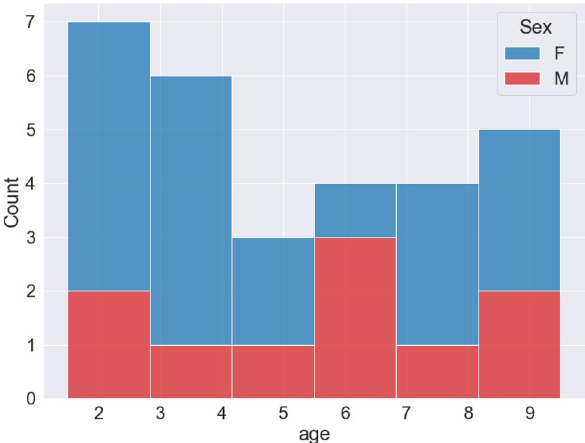
Figure. 1. Number of dogs by age and by sex. The dataset contains slightly more female than male dogs, and slightly more younger dogs than older ones.